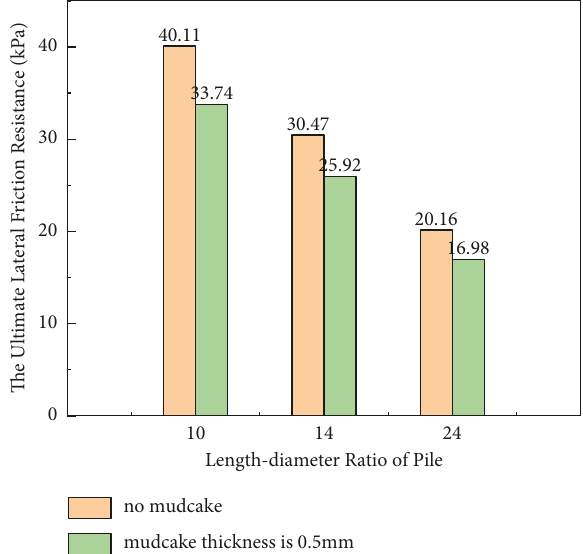
Figure 10: The diagram of the relationship between ultimate lateral friction resistance and length-diameter ratio.